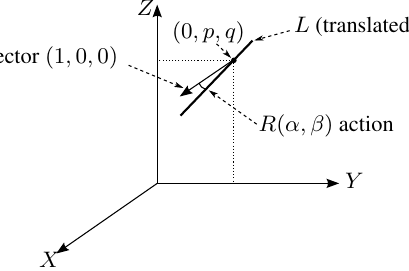
Figure 1: Straight line characterization in object space.